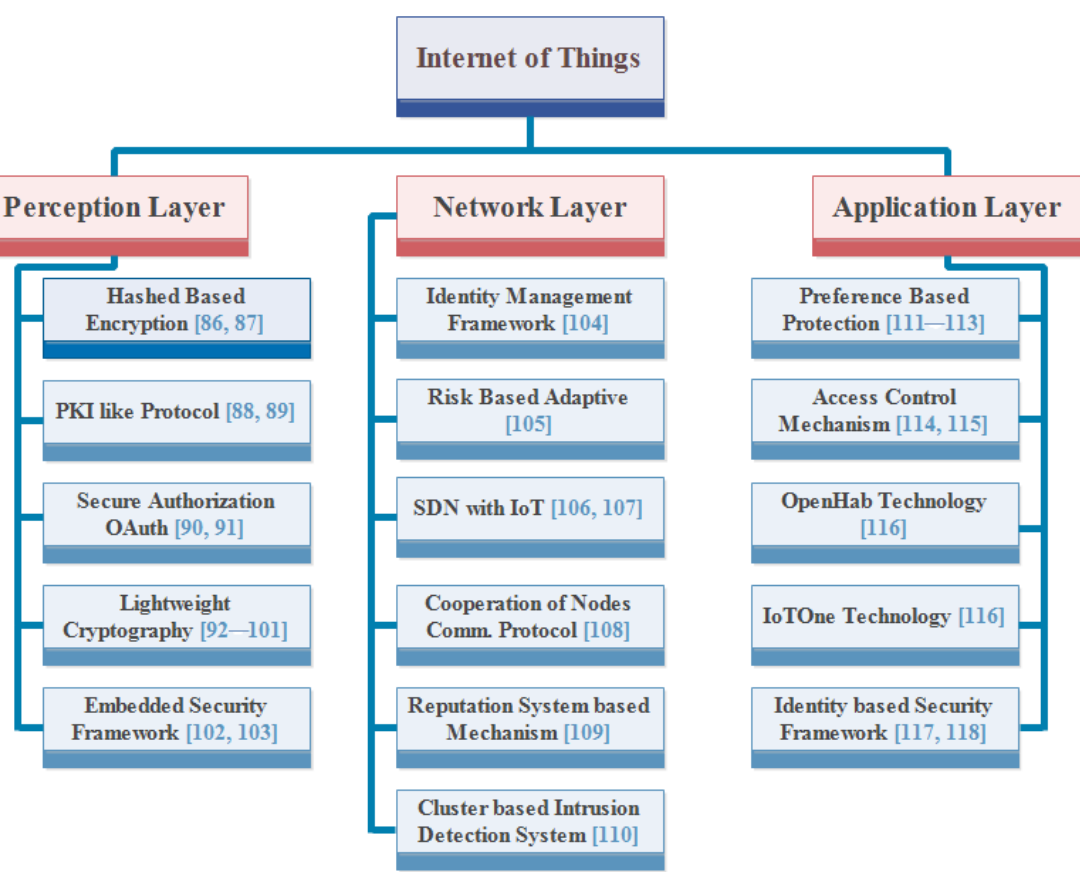
Figure 9. Existing security mechanisms to protect the IoT